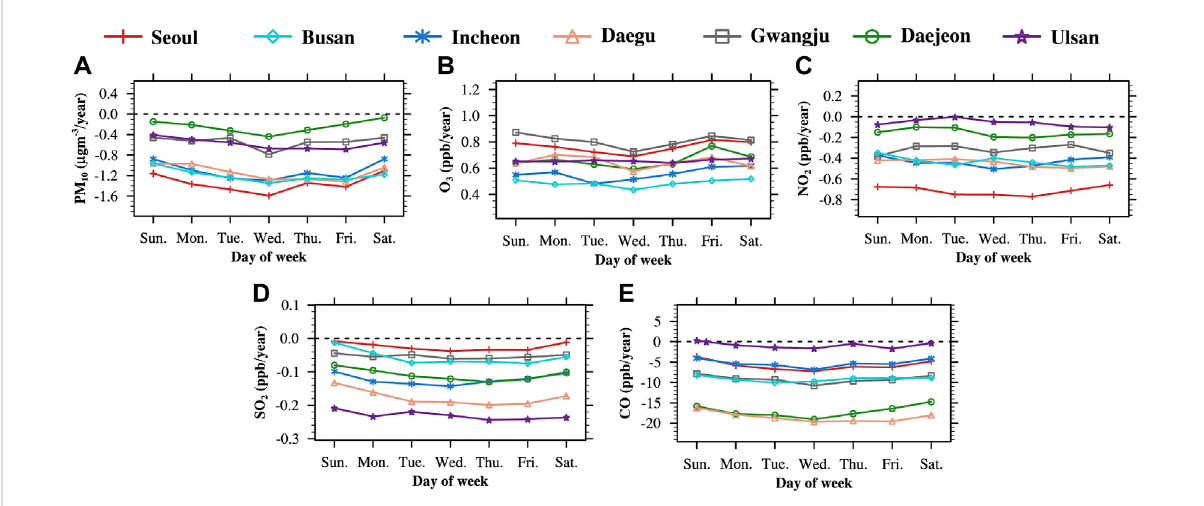
FIGURE 6 For each day of week, long-term (2002 – 2020) trends of median (A) PM 10 ( μ gm − 3 /year), (B) O 3 (ppb/year), (C) NO 2 (ppb/year), (D) SO 2 (ppb/ year), and (E) CO (ppb/year) levels in seven megacities, South